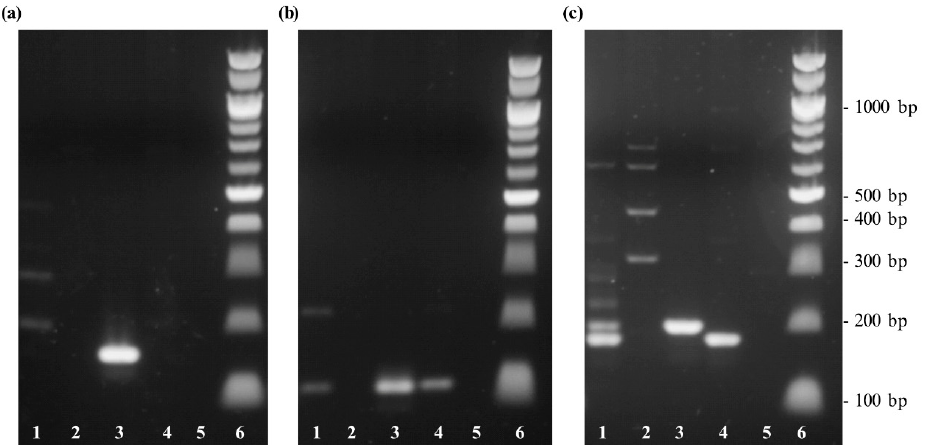
Figure 1. Gel electrophoresis of DNA extracted from different palm species to test the specificity of different sets of primer. Lane 1: Chilean wine palm ( Jubaea chilensis ); lane 2: oil palm ( Elaeis guineensis ); lane 3: coconut palm ( Cocos nucifera ), lane 4: jelly palm ( Butia capitata ); lane 5: non-template sample with water; lane 6: 100 bp DNA ladder. ( a ) PCR amplification with the primer set cocosPRK. ( b ) PCR